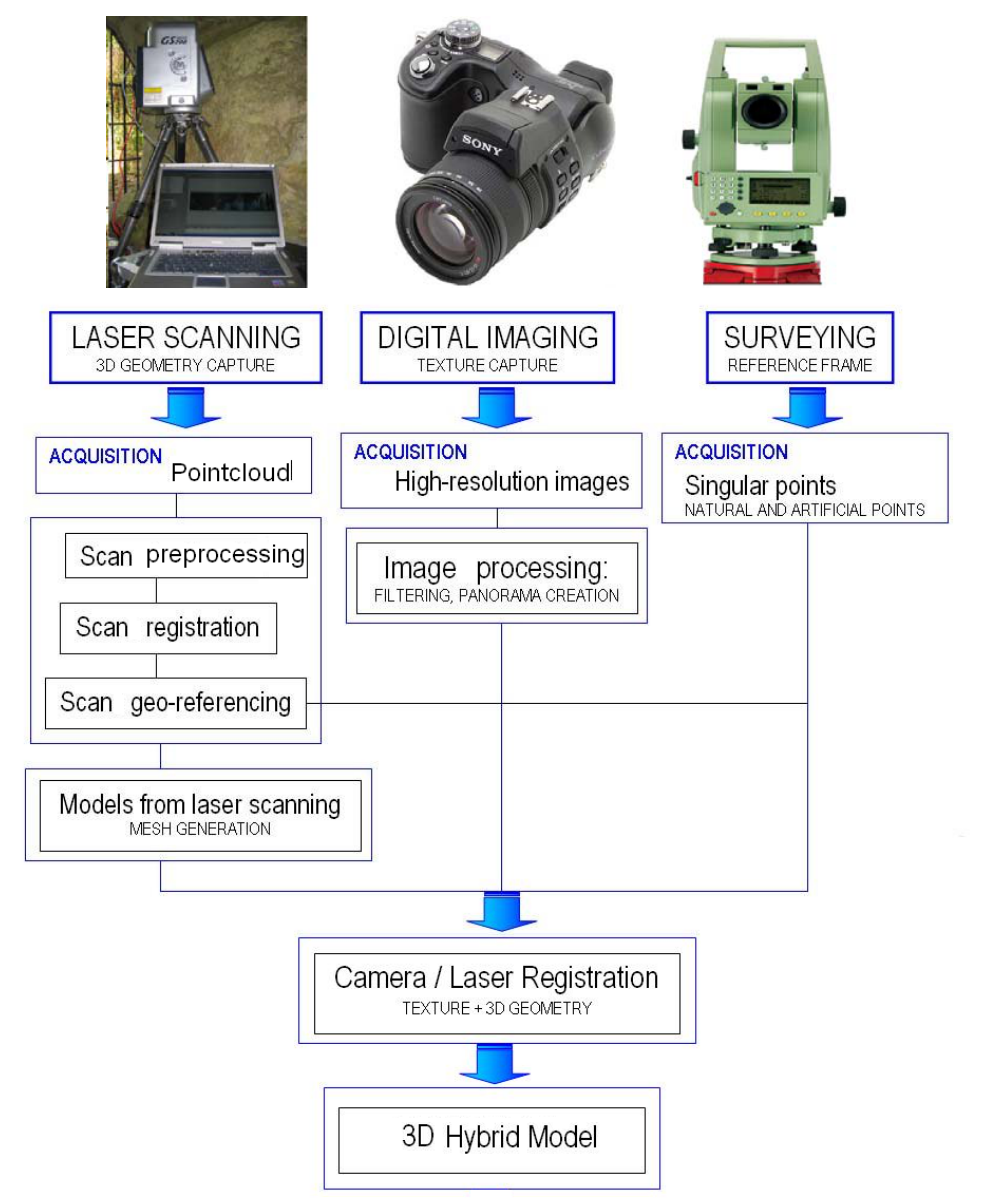
Figure 1 . Multi-sensor approach applied at